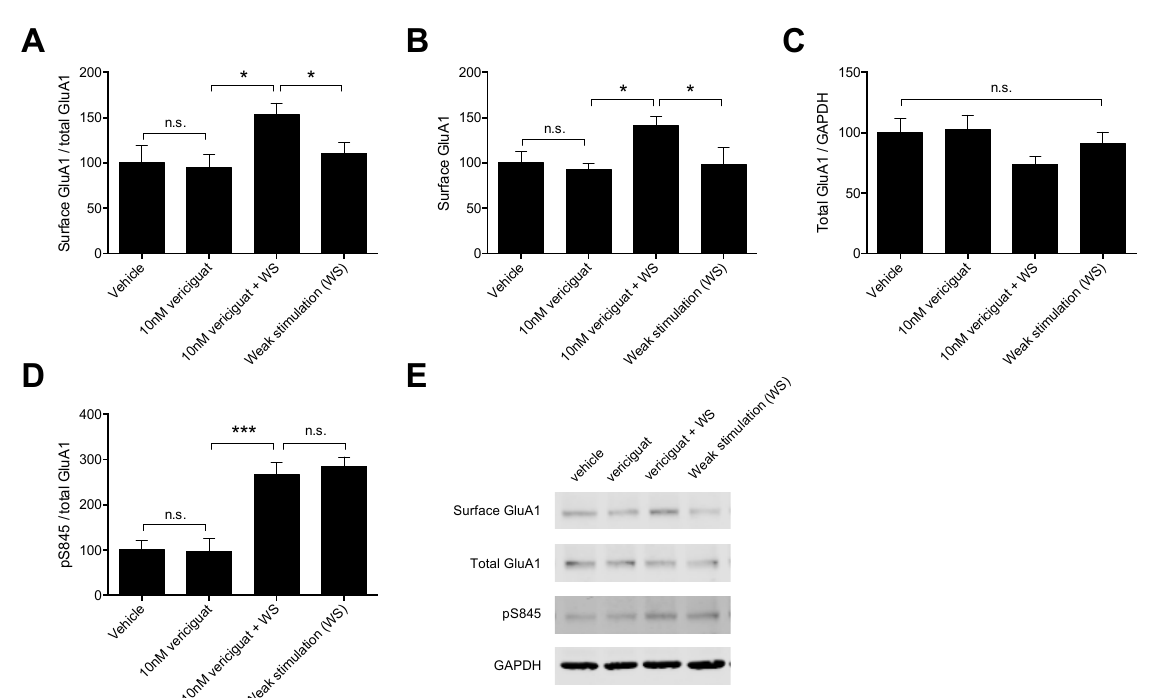
Figure 2. The effects of 10 nM vericiguat on AMPA receptor dynamics in acquisition-like processes in a chemical LTP model. ( A ) A combination of vericiguat with weak stimulation significantly enhanced mobilization of GluA1-containing AMPA receptors (AMPARs) to the surface, which cannot be attributed to effects of the drug alone. ( B ) The increase in surface GluA1-containing AMPAR protein levels together with ( C ) no effects on production of GluA1 suggests that increased trafficking is due to insertion of a pre-existing cytosolic pool of GluA1-containing AMPARs into the plasma membrane. ( D ) This observed increase in membrane insertion of GluA1 seems to be independent of S845 phosphorylation on the carboxy tail of GluA1, since vericiguat did not further enhance the increased pS845 by weak stimulation. ( E ) Representative Western blot for the AMPAR measures. Full Western blot images can be found in Supplemental Figure S1. Data are represented as mean + SEM. Differences between groups were analyzed with a one-way ANOVA and post-hoc LSD tests. * p < 0.05; *** p < 0.001; n = 9–11.